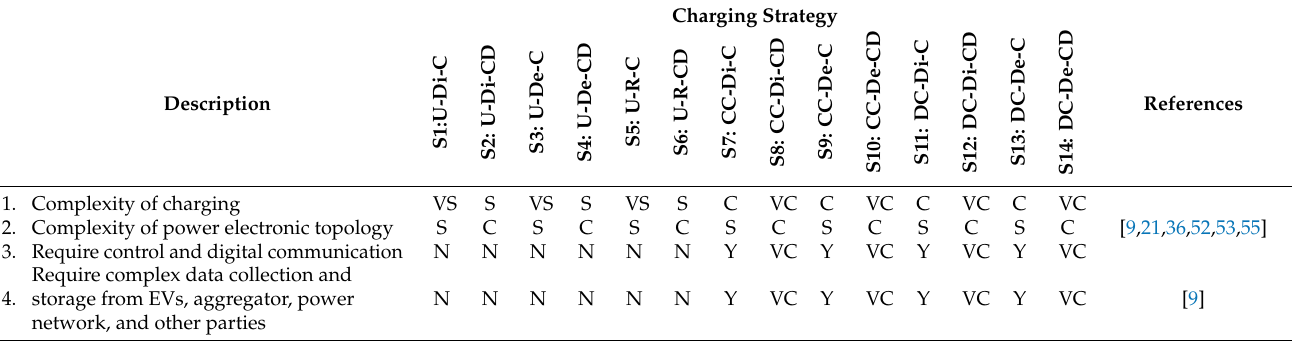
Table 4. Complexity Comparison for Different EV Charging and Discharging Strategies. Charging